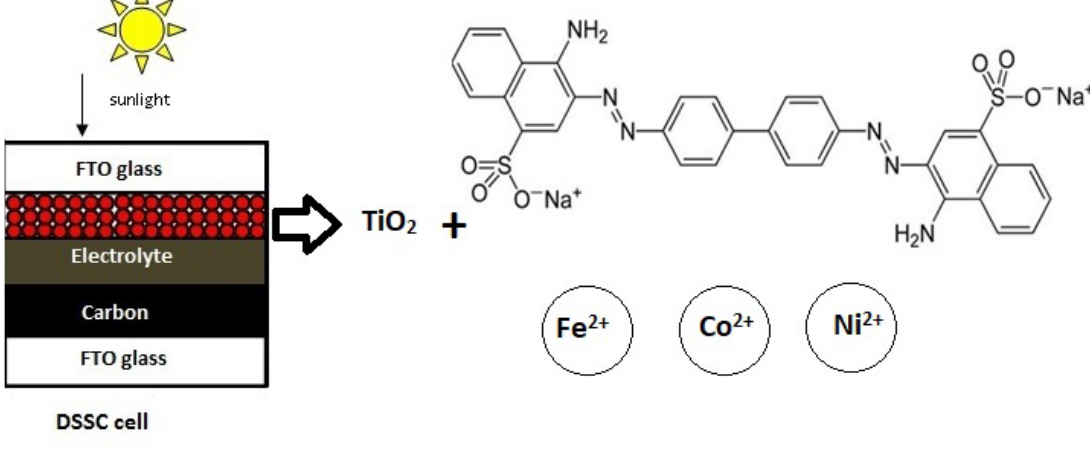
Figure 1: The diagram of DSSC cells, together with the structure of congo red and the three metal ions used to make